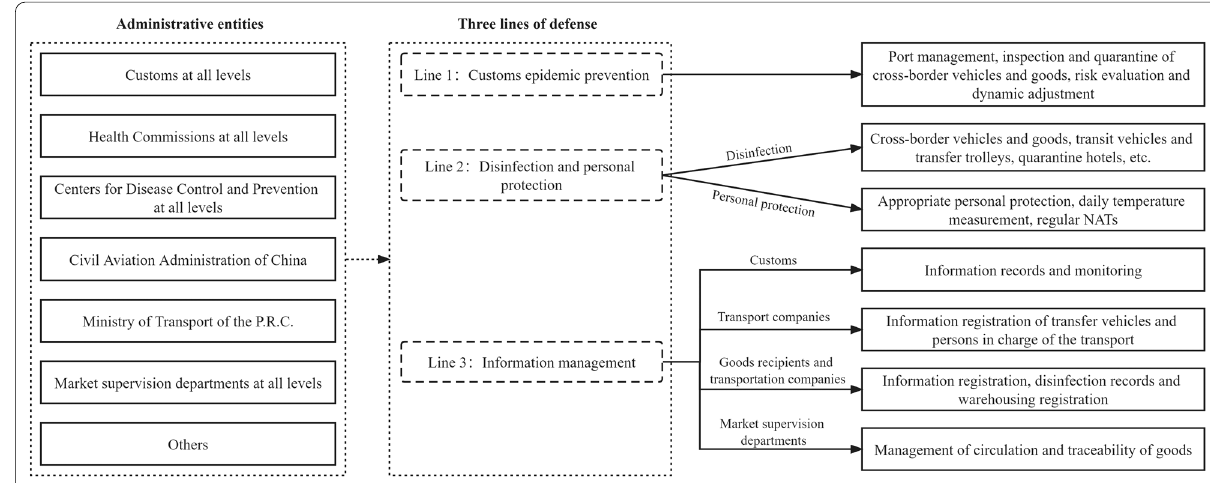
Fig. 2 China’s governance model against imported infections from other